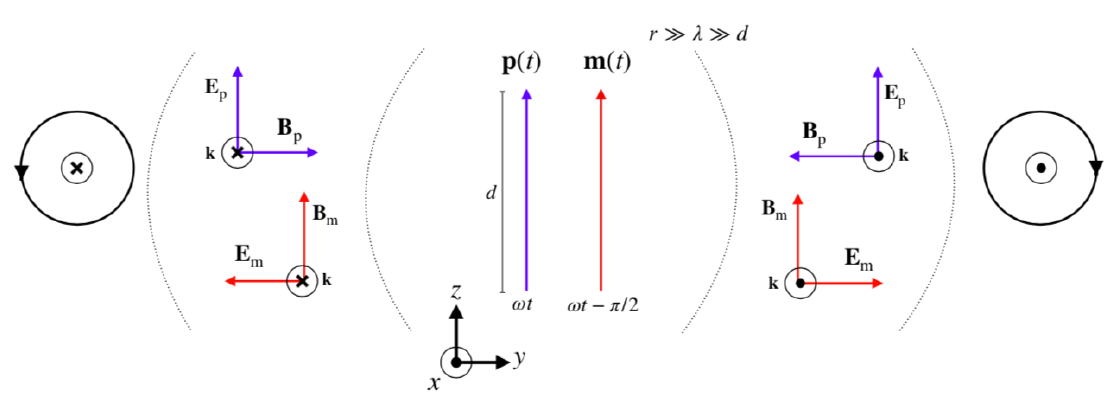
Figure 2. Oscillating electric p ( t ) and magnetic m ( t ) dipoles aligned along the z axis, with the latter lagging by a phase of π /2. The far-field pattern is that of right-circularly polarised light in the + x direction and left-circularly polarised light in the − x direction: there is a net flux of right-circular polarisation in the yz plane.